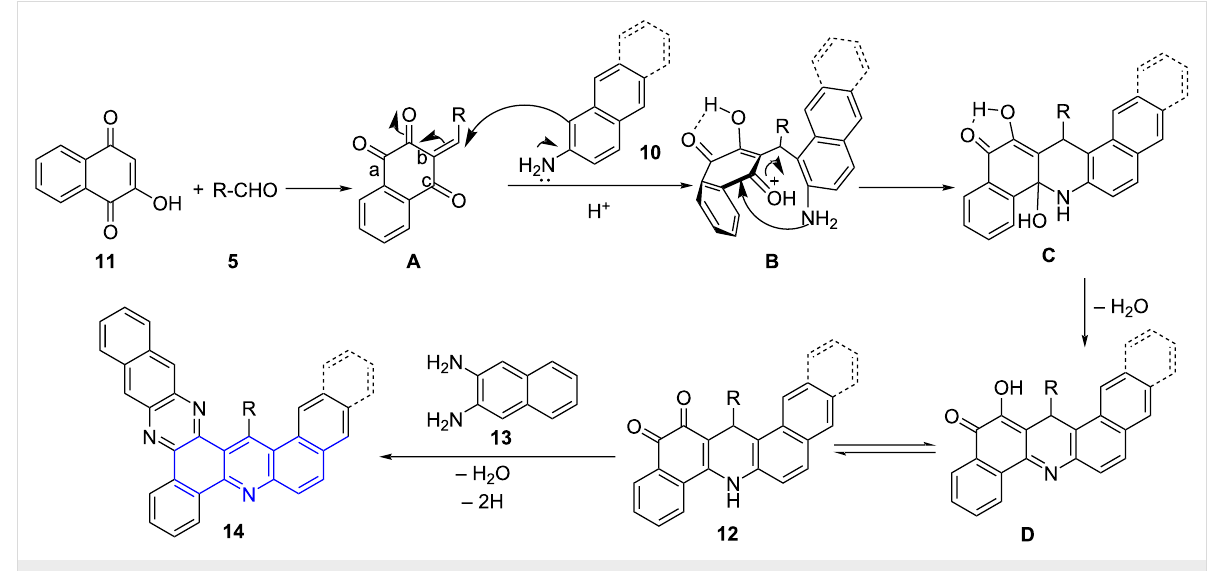
Figure 2: Benzoazepines based potent molecules.